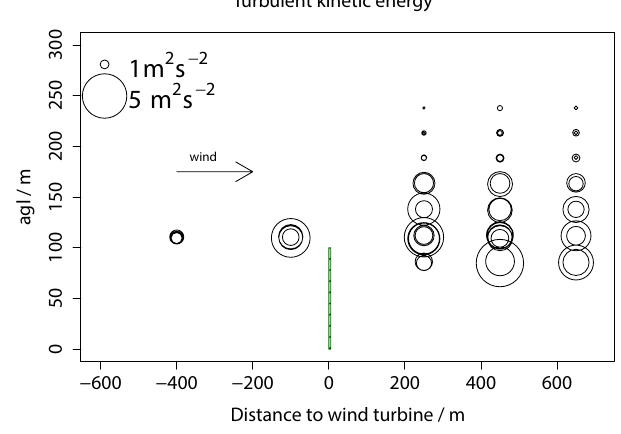
Figure 8. Turbulent kinetic energy measured in flight legs behind a WEC (green line) in different distances and in comparison to up- stream turbulence. Each circle represents one single flight